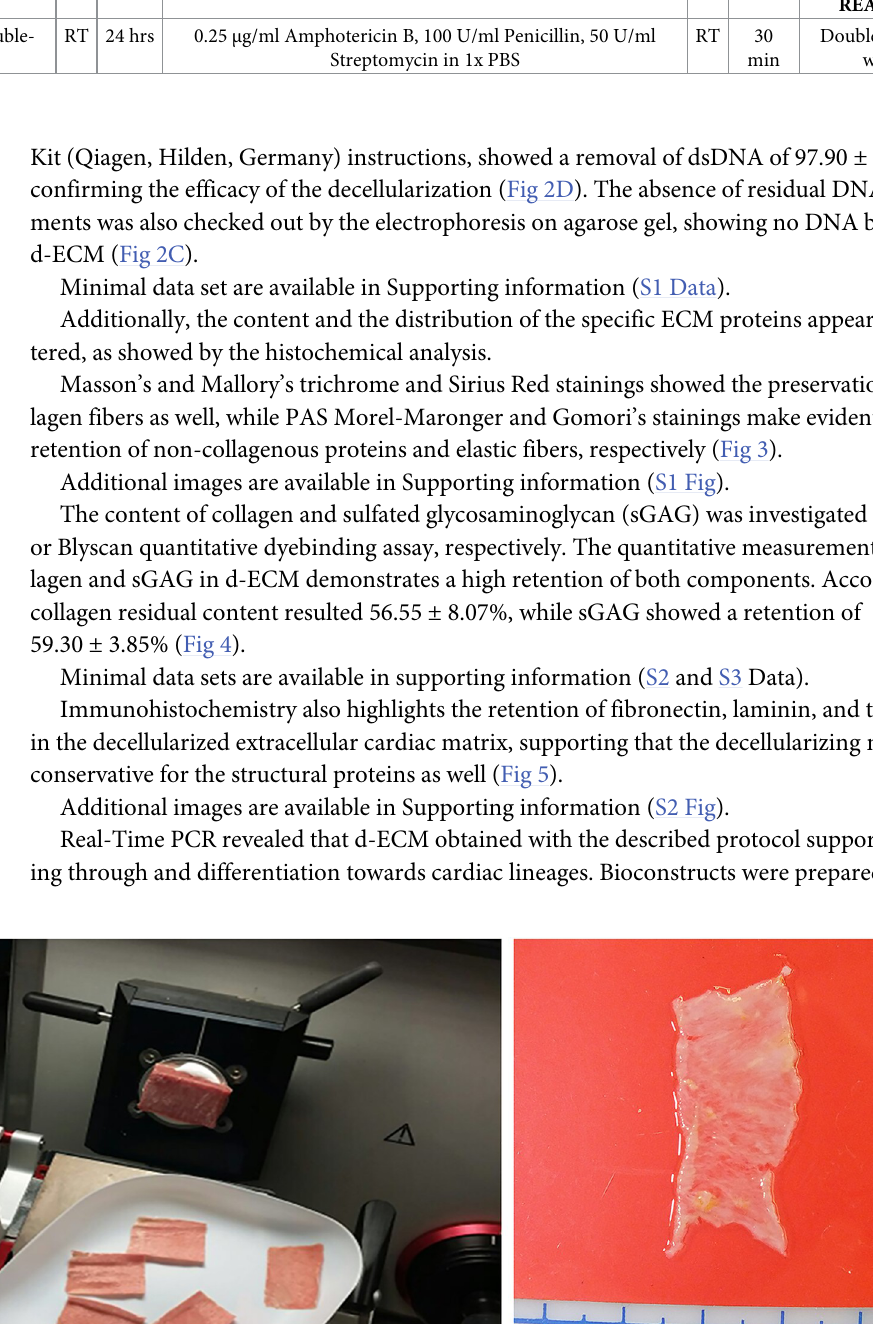
PLOS ONE | https://doi.org/10.1371/journal.pone.0276224 October 19,